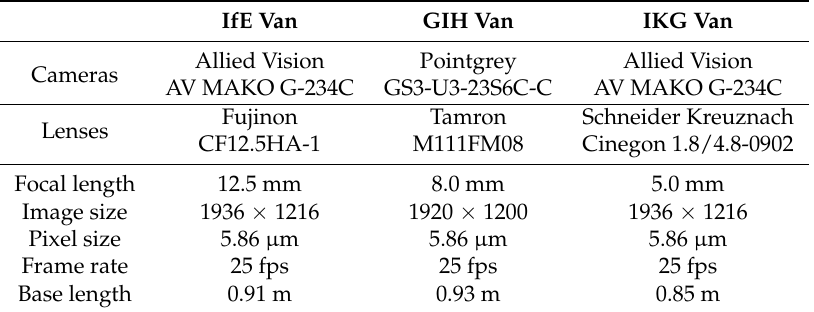
Table 1. Camera setups. IfE, Institut für Erdmessung; GIH, Geodetic Institute Hannover; IKG, Institute for Cartography and Geoinformatics. IfE Van GIH Van IKG